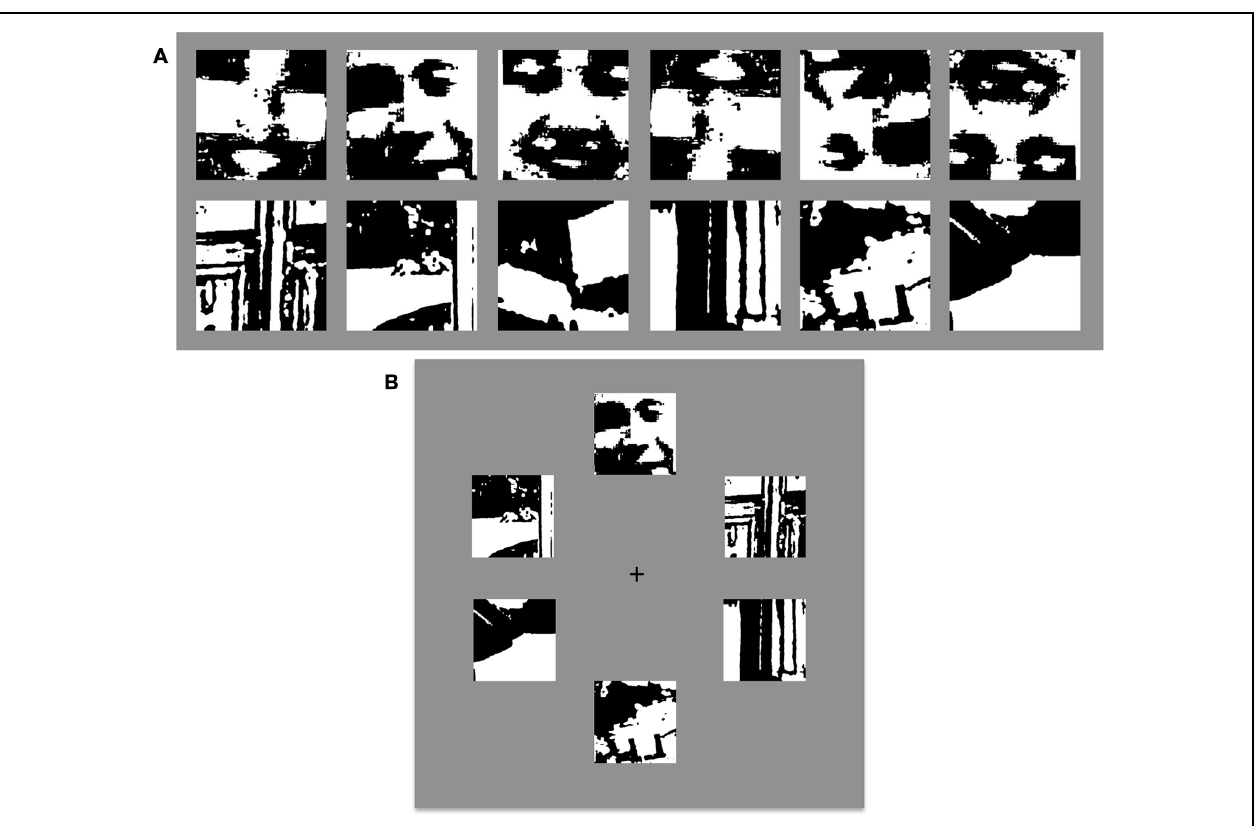
FIGURE 1 | Examples of Mooney Stimuli and Paradigm. (A) Top row: Examples of Mooney face targets both upright (first three) and inverted (last three). Bottom row: Examples of distractor stimuli. (B) An example of a visual display containing a Mooney face target (at the top position) and 5 Mooney, non-face distractors.